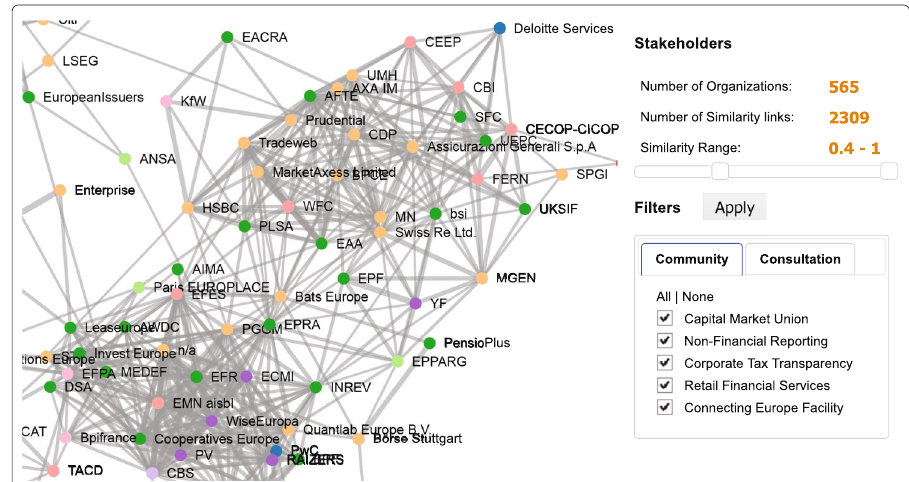
Fig. 5 A screenshot of the LobbyProfileExplorer . On the right-hand size, the user can select consultation topics of interest for further explorations